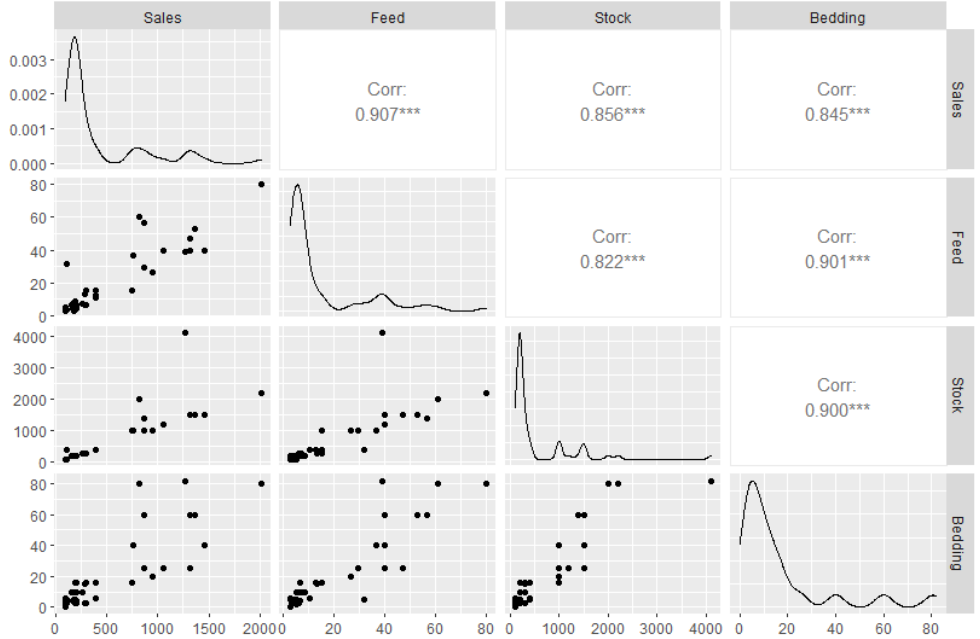
Figure 2. Output and input correlations along with their density plots and scatter plots for the entire sample. *** p <